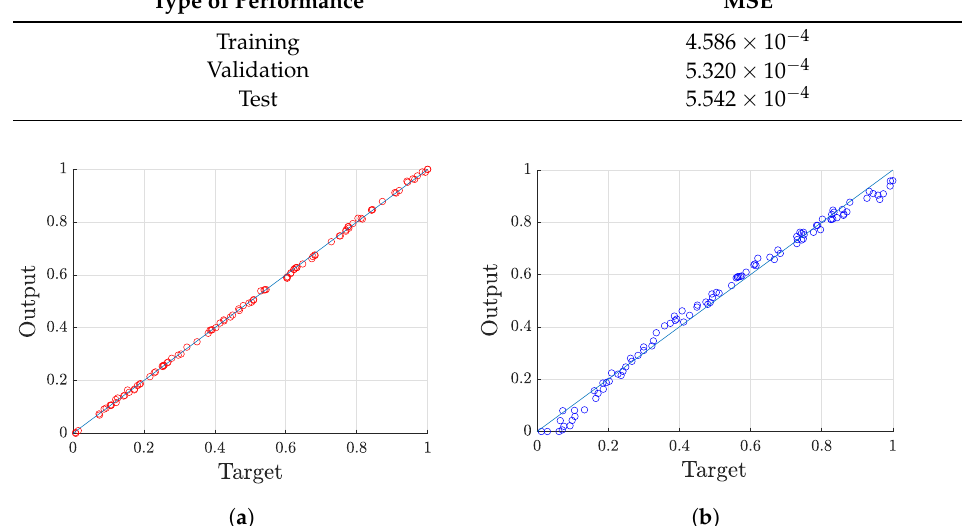
Figure 14. The values on the x-axes are the actual values of the parameters (normalized between 0 and 1), while the values on the y-axes are those predicted by the network. This figure shows the individual fits for the following cases: ( a ) FDJ of Extended Case A; ( b ) η O of Extended Case